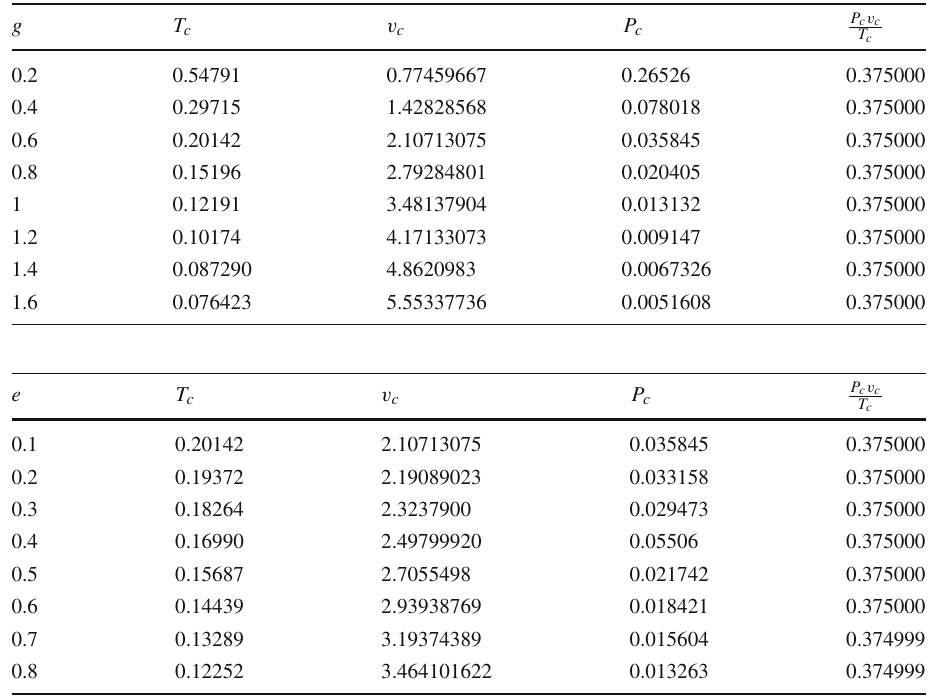
Table 4 At a 2 = 2 and g = 0 .